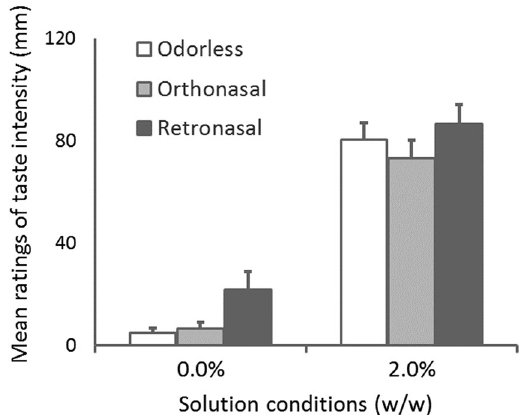
Figure 4. Mean ratings of taste intensity for Experiment 1. Error bars indicate standard error (n = 10). A two- way ANOVA showed significant main effects of solution (F (1, 9) = 53.2, p = 0.00005, η p2 = 0.86) and odor (F (2, 18) = 8.1, p = 0.003, η p2 = 0.47), but the interaction between factors was not significant. Post hoc analysis showed that the ratings of taste intensity for the retronasal route condition were significantly higher than those for the orthonasal route condition (p = 0.025, η 2 = 0.58) and were marginally higher than those for the orthonasal route condition and odorless condition (p = 0.018, η 2 = 0.59: p = 0.048, η 2 =